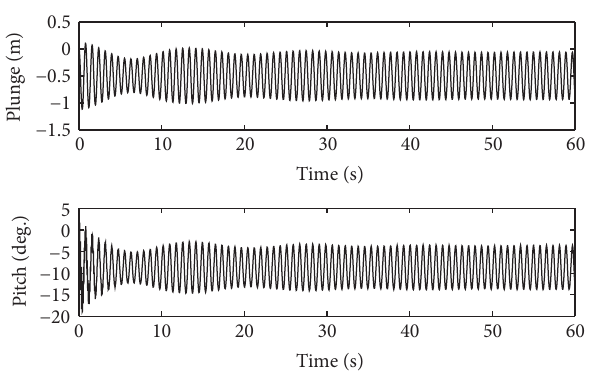
Figure 5: Pitch and plunge responses at deep stall flutter.